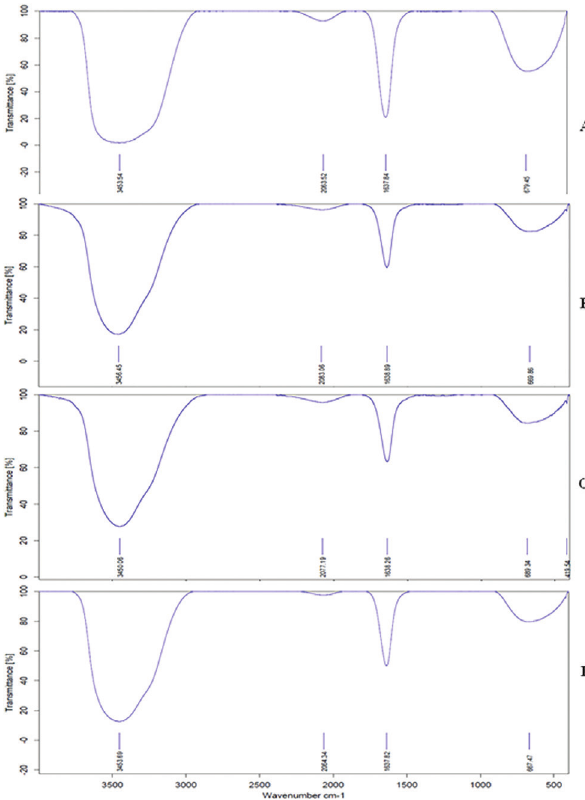
Figure 1: FT-IR spectrum of E. coli (a), S. aureus (b), B. cereus (c) and S. e. subsp. enterica (d)